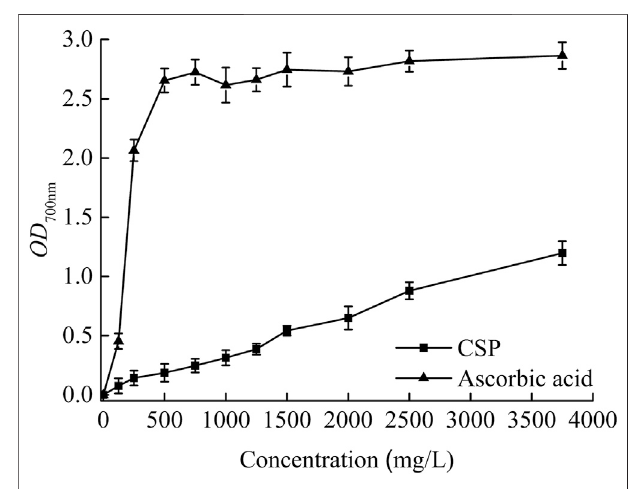
FIGURE 5 | Fe 3+ reducing antioxidant power of